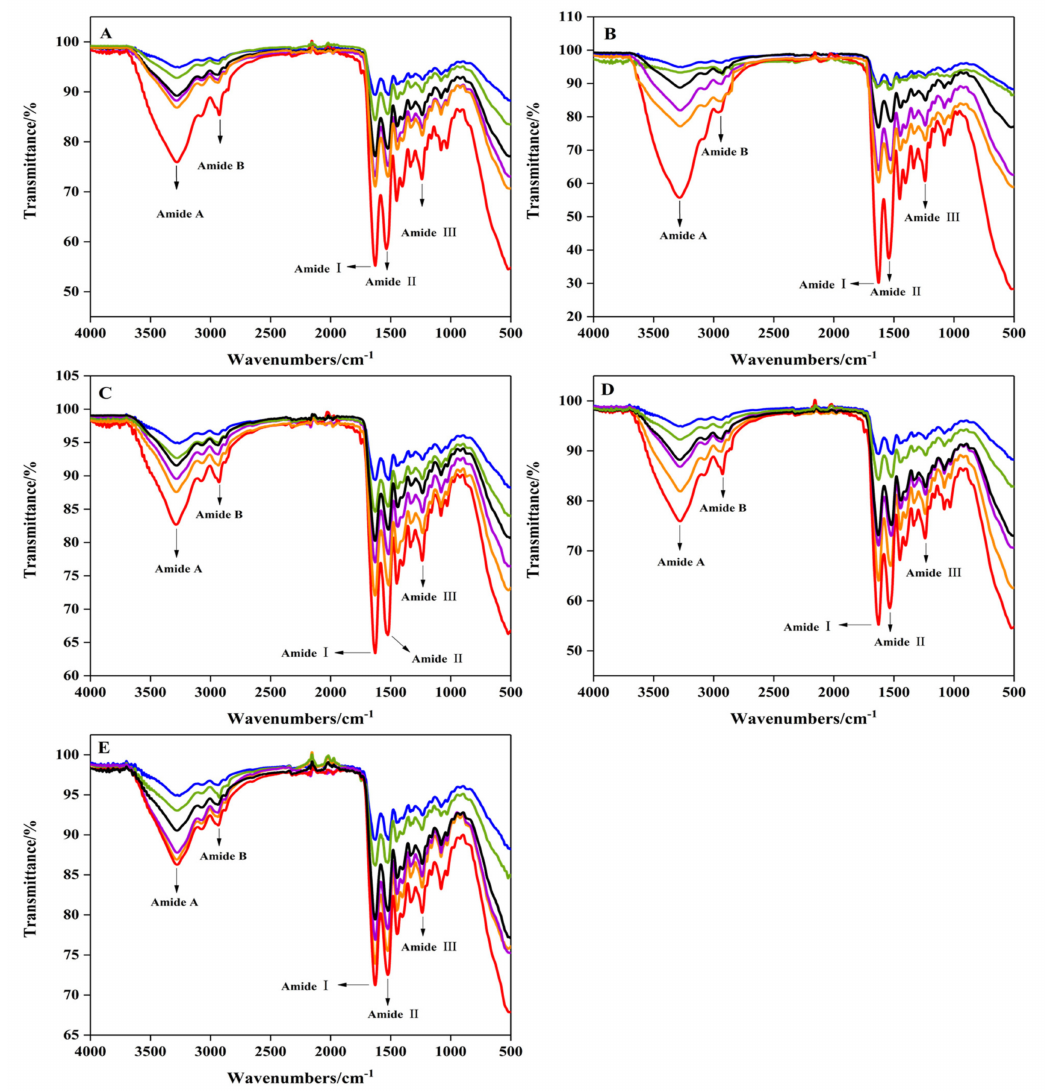
Figure 2. The effect of high hydrostatic pressure processing on the FTIR spectrum of cowhide collagen. High pressure 5 min ( A ); high pressure 10 min ( B ); high pressure 15 min ( C ); high pressure 20 min ( D ); high pressure 25 min ( E ). 0 MPa ( ); 200 MPa ( ); 250 MPa ( ); 300 MPa ( ); 350 MPa ( ); 400 MPa ( ). Amide A (amide A band in the FTIR spectrum); amide B (amide B band in the FTIR spectrum); amide I (amide I band in the FTIR spectrum); amide II (amide II band in the FTIR spectrum); amide III (amide III band in the FTIR